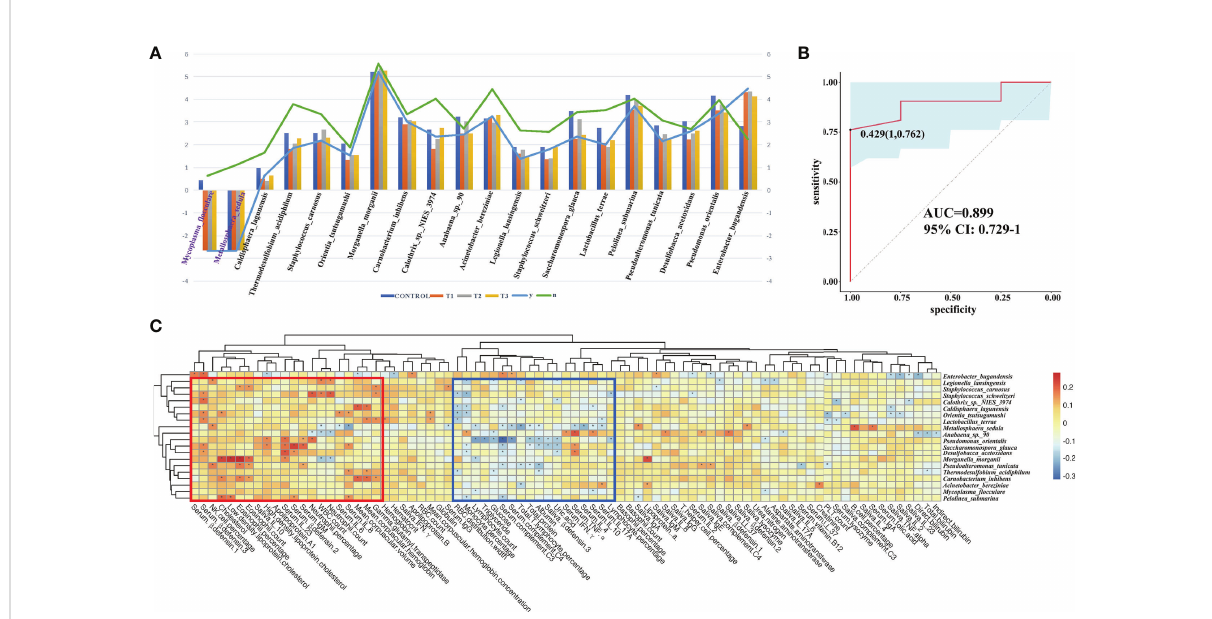
FIGURE 9 Relapsable characteristics of gut microbiota in RAU patients after thalidomide withdrawal. (A) The signi fi cantly different species between the replasable and replase-free individuals. (B) Receiver operating characteristic curves for fecal microbial species comprising samples from replasable and replase-free individuals. “ 1 ” is the sensitivity of the optimal threshold point, and “ 0.762 ” is the speci fi city. “ 0.429 ” is the socre of adaboost modle at the optimal threshold point. The blue area 95% con fi dence represents the con fi dence interval. (C) Correlation heatmap of relapse-associated species and the blood and saliva factors between replasable patients and replase-free individuals. Blue boxes denote the cluster of negative correlation, those encompassed by the red box represent the cluster of positive correlation. The colors are proportional to the correlation strength, the variation from red to blue represent positive to negative trend. “ * ” means P